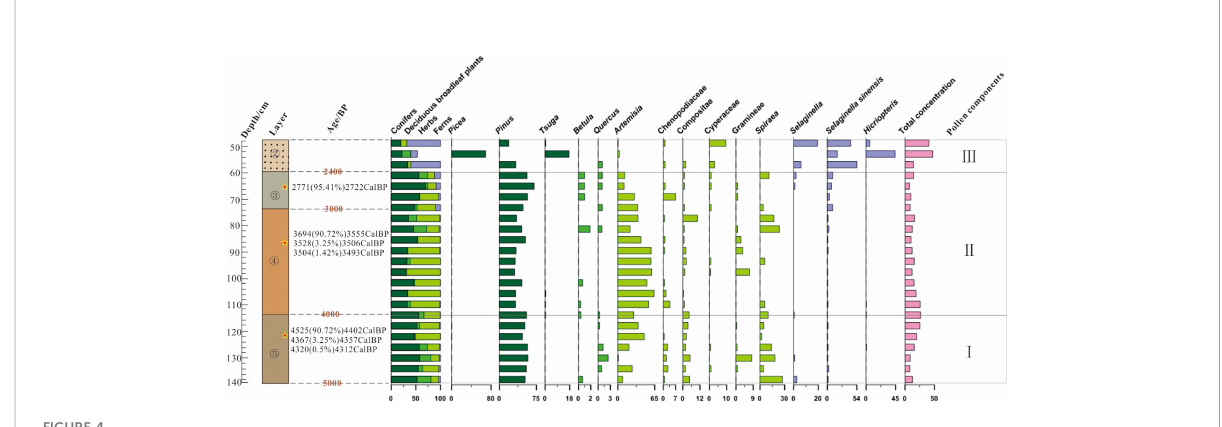
FIGURE 4 Palynogram of the FTG